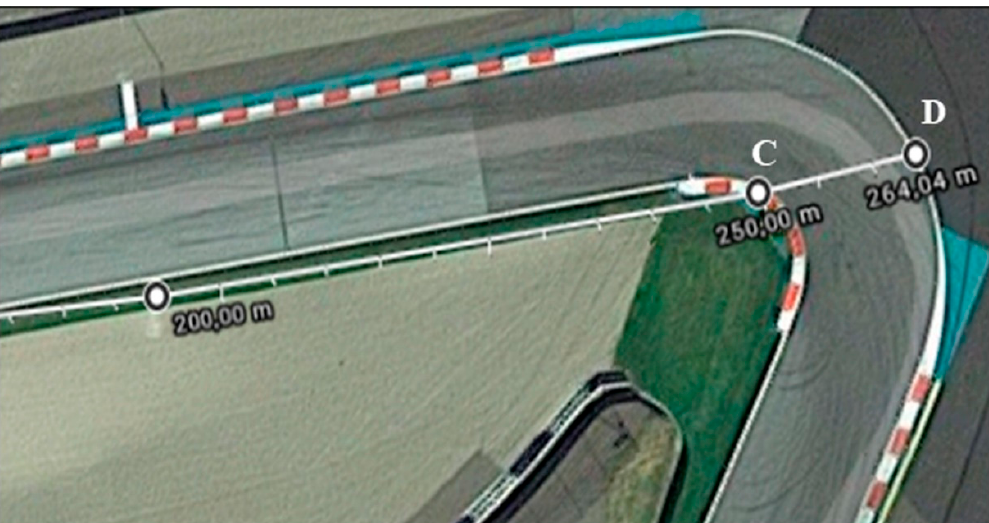
Figure 5. Satellite image showing the section of the straightaway leading into turn 3. Point C corresponds to a marker on the internal curb of turn 3, the point where Morbidelli’s bike began cartwheeling across the track. Point D is shown by a marker on the outer edge of turn 3 with a trajectory that follows the line of the straightaway, the same trajectory that Morbidelli’s bike followed as it cartwheeled across the curve. The line from C to D measures 14 m.